Question: What style of plot is this figure drawn as?
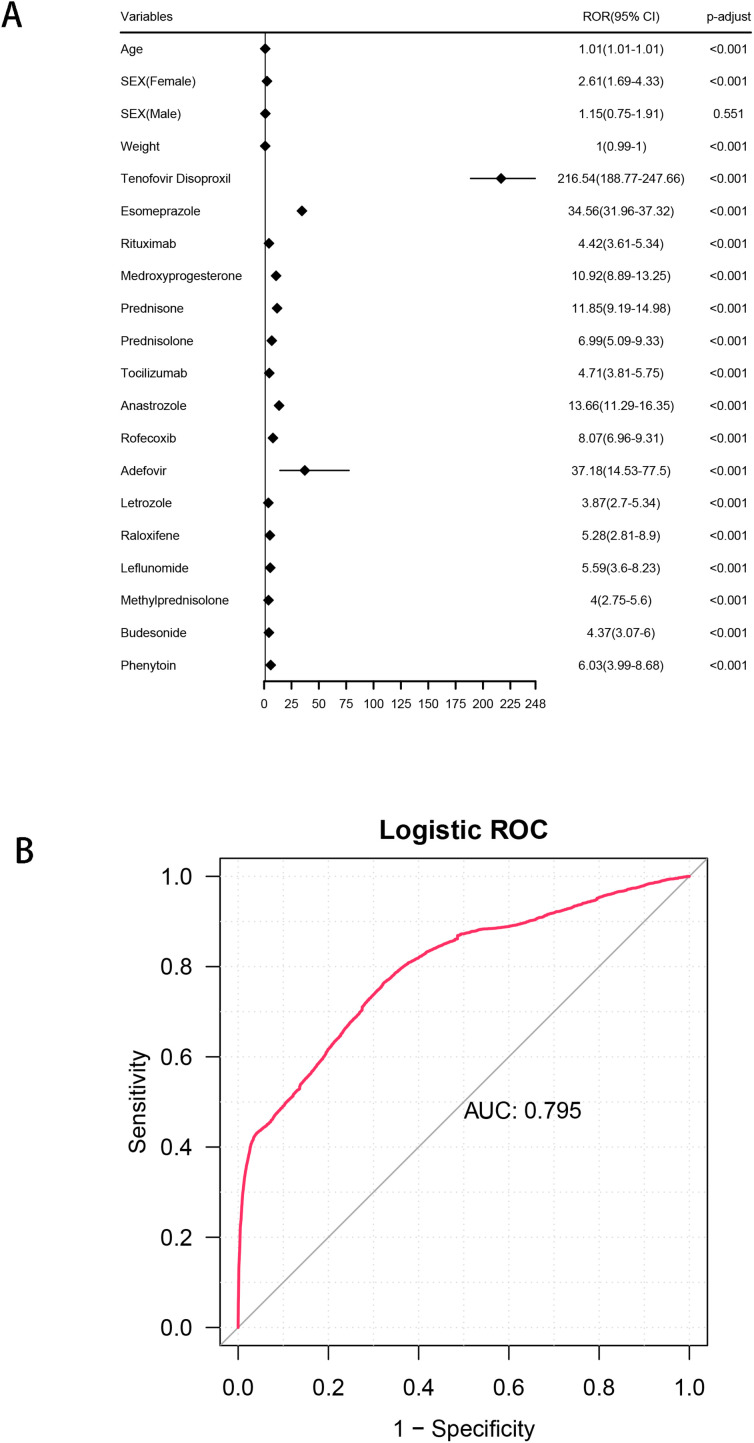
Answer: line